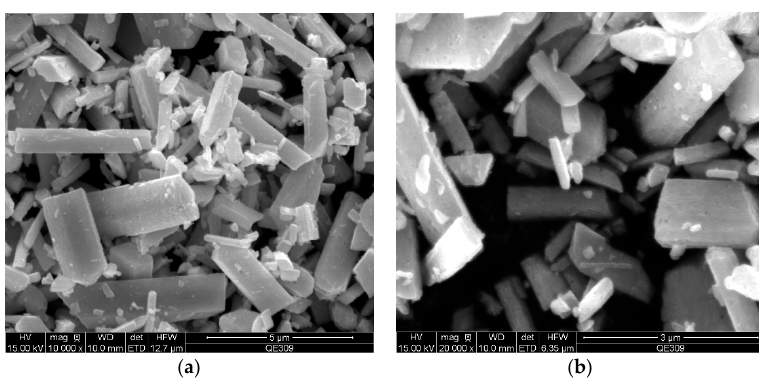
Figure 1. Morphology of Ga 2 O 3 particles: ( a ) 10,000 times; ( b ) 20,000